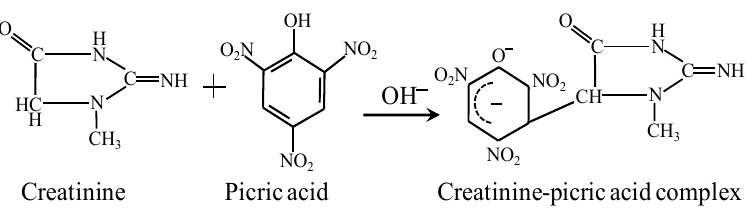
Scheme 1. Jaffé reaction between creatinine sample and picric acid/NaOH indicator.